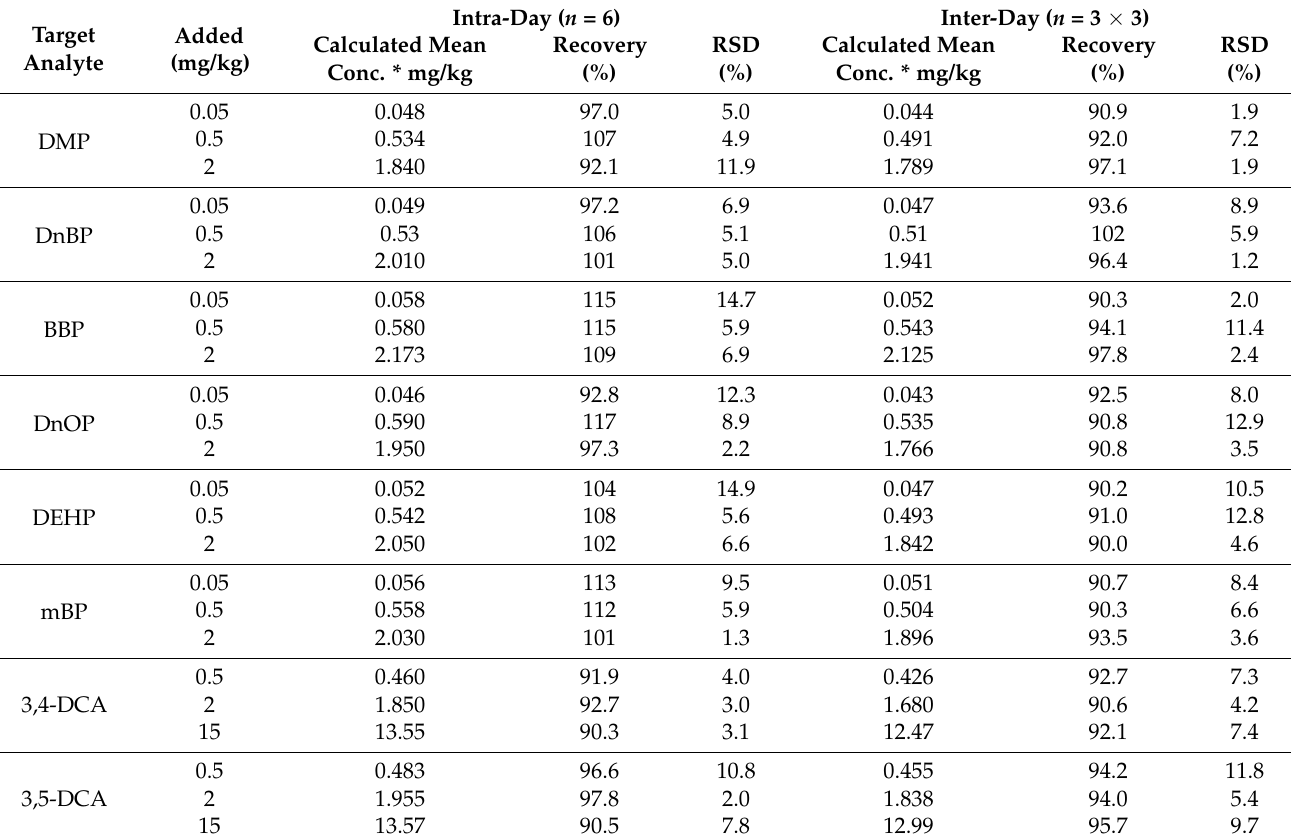
Table 3. Precision and trueness results for the analysis of target analytes in spiked